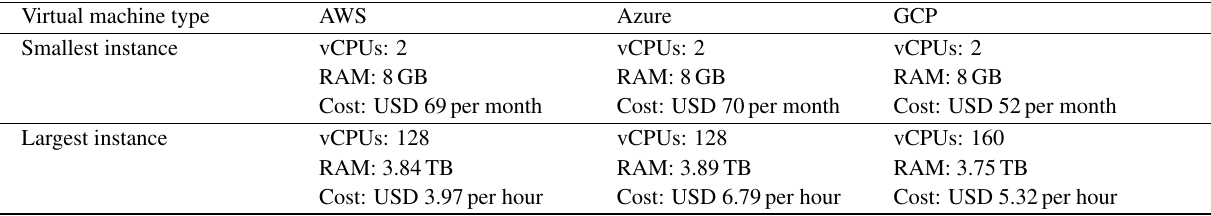
Table 8 Pricing models of the top three CSPs at the virtual machine level.